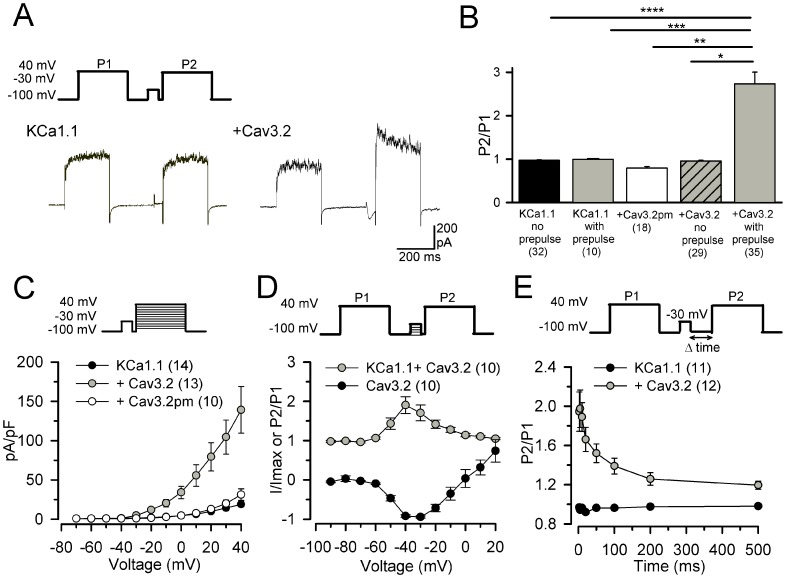
Cav3.2 channels increase KCa1.1 current by shifting activation to hyperpolarized potentials.Shown are whole-cell patch clamp recordings from tsA-201 cells transiently transfected with Cav3.2 or KCa1.1 cDNA. A, Representative KCa1.1 currents evoked with or without coexpression of Cav3.2 channels. KCa1.1 activation was tested by 250 ms steps to +40 mV (P1, P2) and the P2 pulse immediately preceded by a 50 ms test pulse to −30 mV (2 ms return to −100 mV) to maximally activate Cav3 current. B, Bar plots showing the fractional change (P2/P1) in KCa1.1 current elicited by the protocol in (A) and with Cav3.2 channels substituted with a Cav3.2 pore mutant (Cav3.2pm) that does not conduct calcium. C, Current-voltage plots indicating that a pre-pulse to −30 mV to activate Cav3 current (see inset) significantly shifts KCa1.1 activation to more hyperpolarized potentials. KCa1.1 activation is unaltered when coexpressed with Cav3.2pm. D, Plots of the P2/P1 ratio of KCa1.1 current evoked at +40 mV in a tsA-201 cell as a function of the voltage of a 50 ms pre-pulse command delivered in 10 mV increments from −90 mV to +20 mV (see inset). Note the close correspondence in voltage-dependence and magnitude of Cav3.2 and KCa1.1 currents. E, Time dependence of KCa1.1 activation from the effects of a pre-pulse to −30 mV (time 0) with test pulses to +40 mV (see inset) delivered at the indicated time intervals in cells with or without coexpression of Cav3.2 channels. Capacitance artefacts in (A) were digitally reduced for display purposes. Sample sizes are shown in brackets.